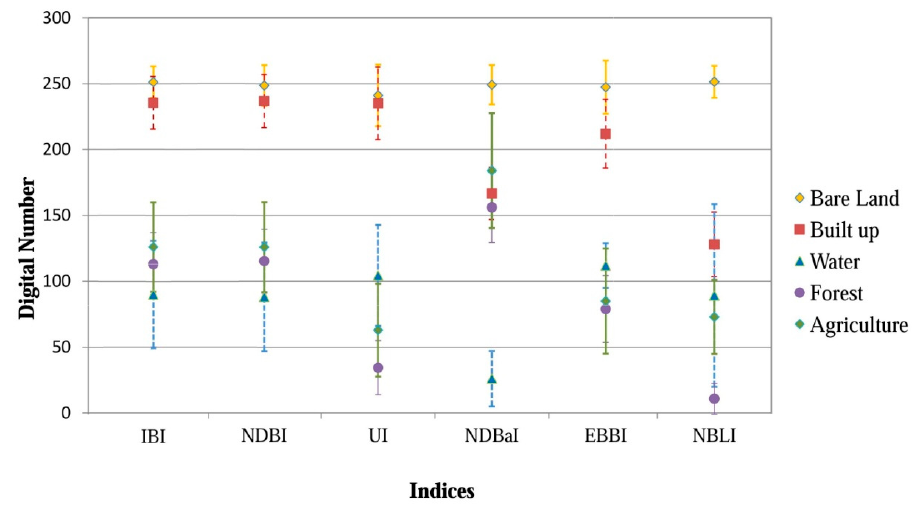
Figure 4. Statistics of typical land covers in different index images. Here, the marks indicate the mean value of a class, and the bar represents its standard deviation. All values are stretched into [0, 255].